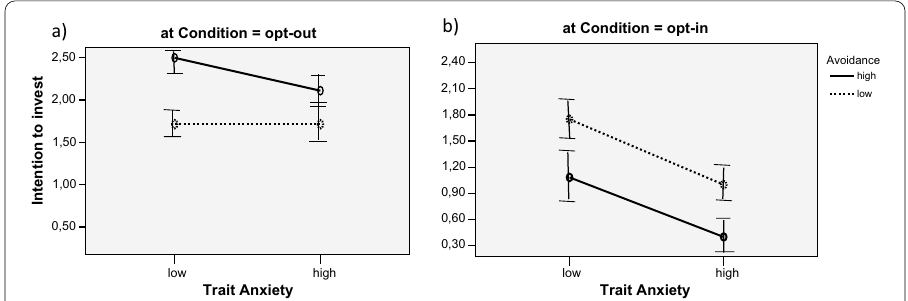
The dependent variable ranged from 0 to 3. Condition was coded as 1 (opt‑out) and ‑1 (opt‑in). CondXTA between condition and Trait Anxiety; CondXAV between condition, Trait Anxiety and Avoidant style